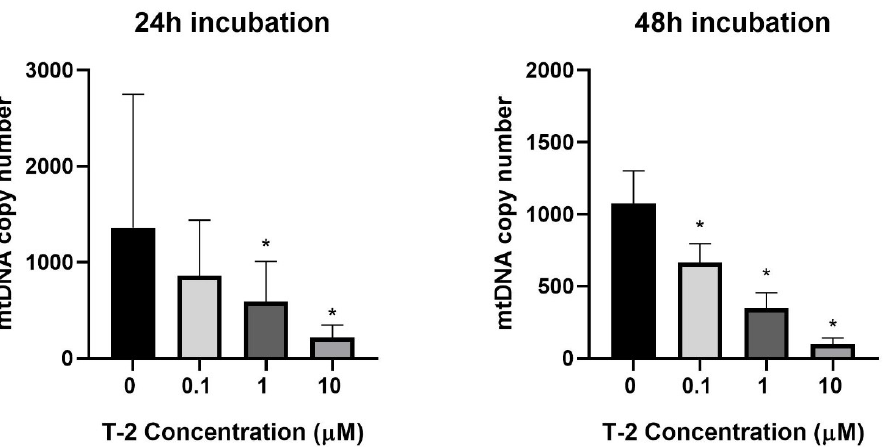
Figure 2. The T-2 toxin’s effect on intracellular ROS production in the Hs68 cell line, measured as the DCF fluorescence intensity. The values are presented as means ± SD ( n = 6).